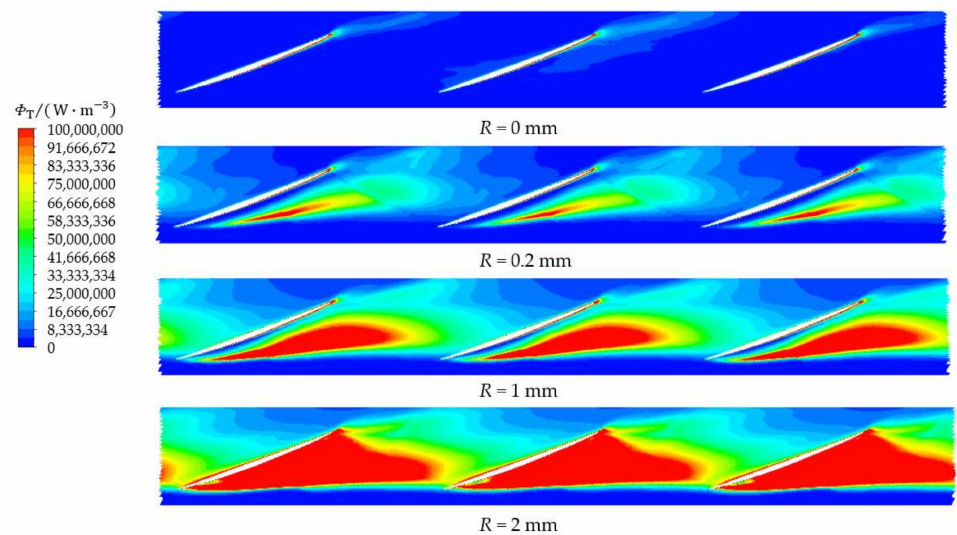
Figure 15. Cylinder distribution of internal dissipation rate of impeller under pump condition ( r ∗ =